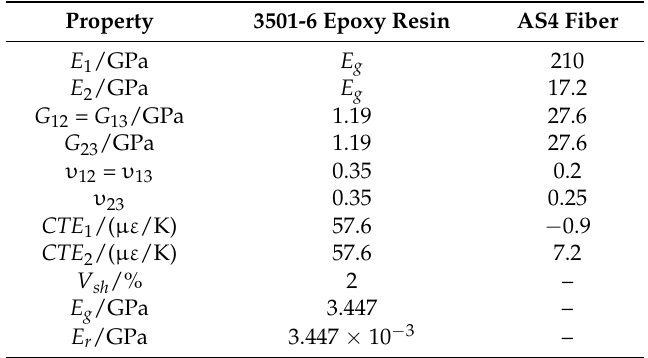
Table 3. Mechanical properties for AS4 carbon fiber and 3501-6 resin